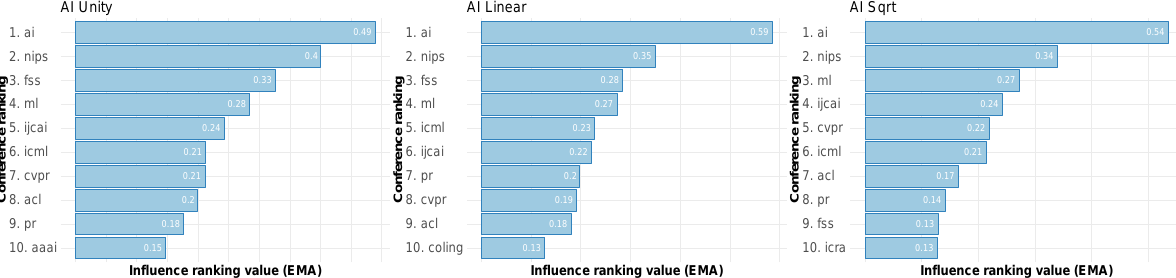
Figure 4. The comparison of top 10 ranking of AI conferences – the result of RI value calculation (Algoritm 3), using Citation Ratio and three different priority